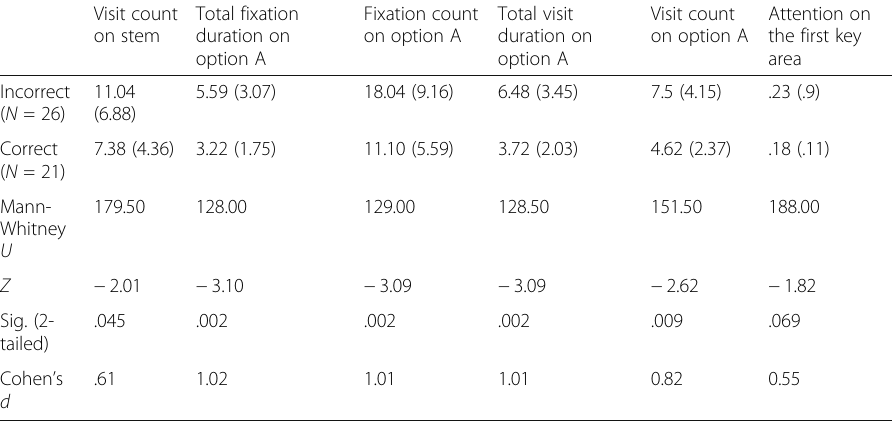
Table 9 Eye-tracking statistics for item 7